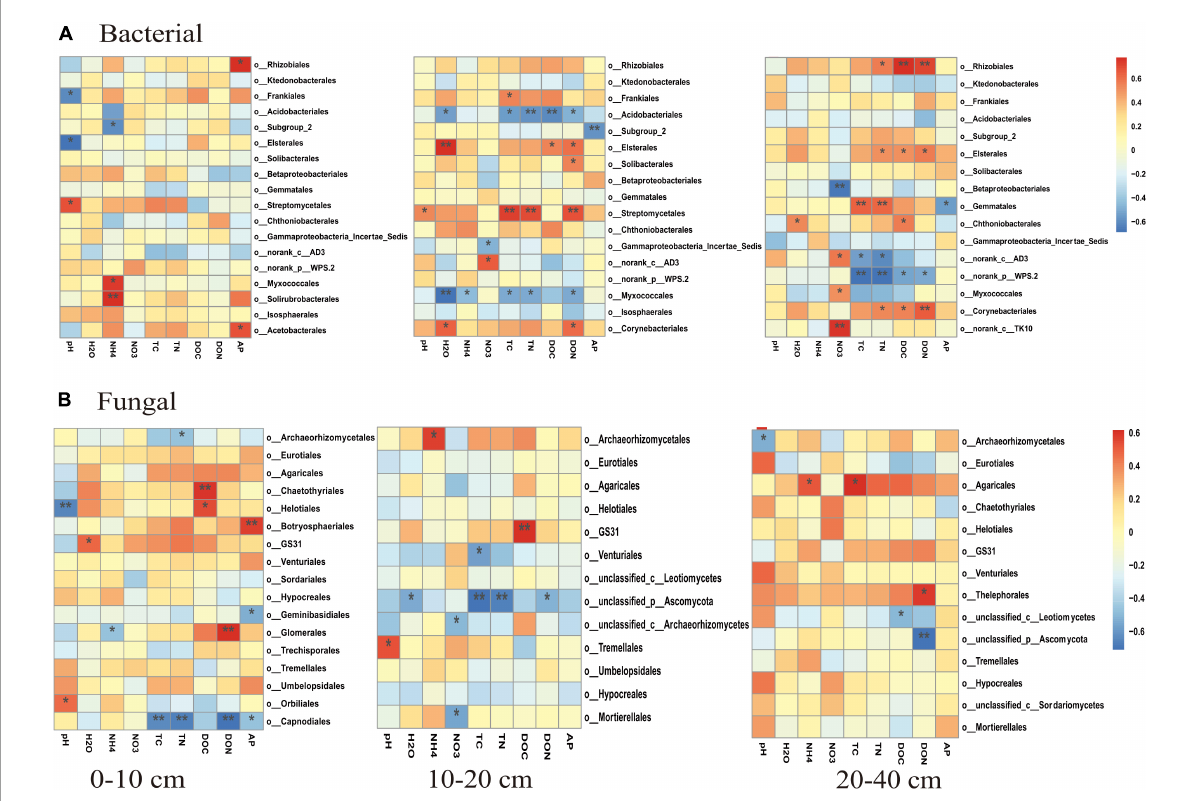
FIGURE7 Correlations (as indicated by Pearson correlation coefficients) between soil properties and relative abundances of major bacterial taxa ( > 1.0%, A–C ) and fungal taxa ( > 0.5%, D–F ) at the order level in different soil layers. Blue indicates a negative correlation, and red indicates a positive correlation; the strength of the color indicates the strength of the correlation. * and ** indicate significant correlations at p < 0.05 and 0.01,